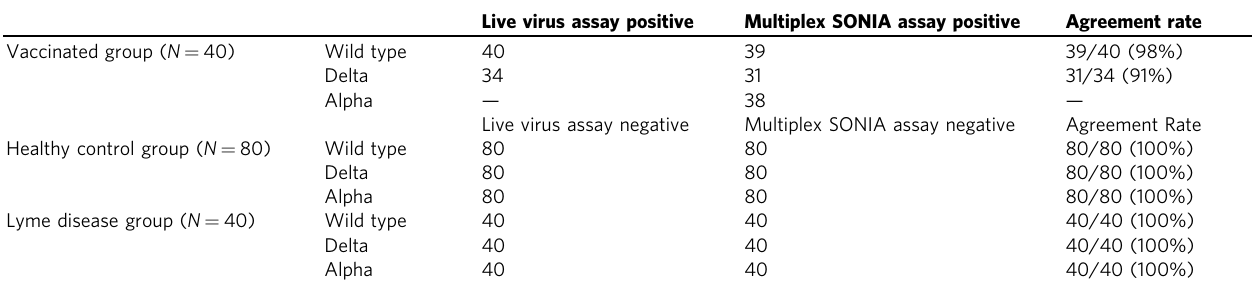
Matched serum and dried blood spot samples were obtained from the participants. Multiplex SONIA assay was performed on the dried blood spot specimens, and the live virus assays were performed for the wild type and delta strain for the vaccinated